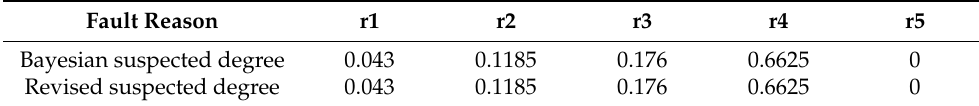
Table 11. Suspected degree of fault reasons.